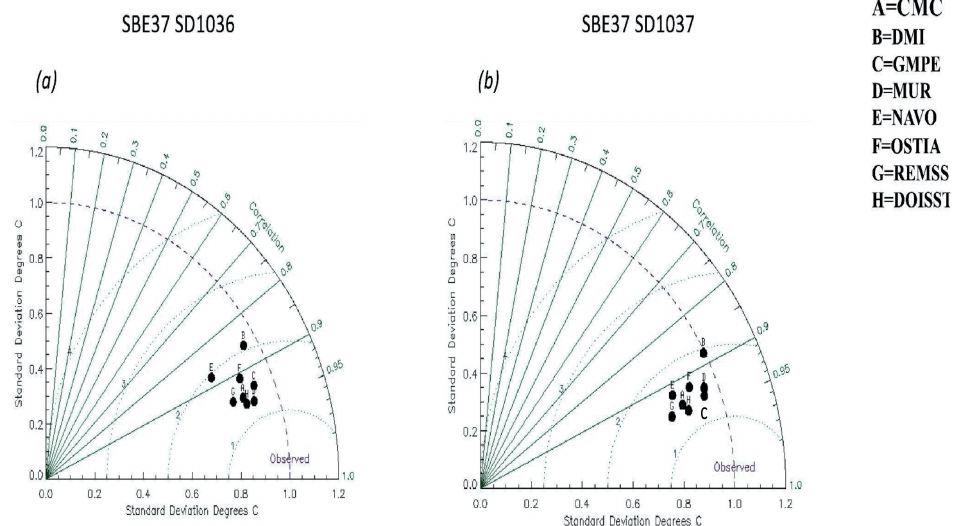
Figure 6. Normalized Taylor diagram showing differences for GHRSST L4 SST products (used as reference), relative to the SBE37 SSTs on ( a ) SD1036 and ( b ) SD1037. The trimmed MUR is used in these comparisons.